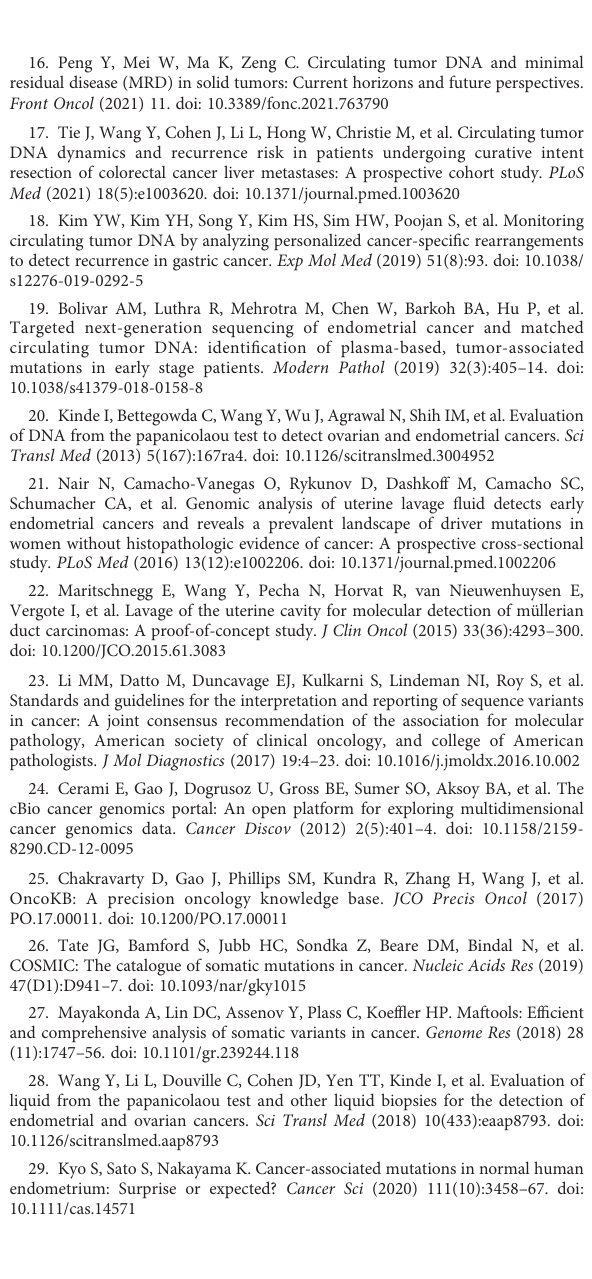
SUPPLEMENTARY FIGURE 2 Genetic alteration pro fi le. (A) Most commonly altered genes based on cervical swab-based genomic DNA (left) and whole blood-based circulating tumor DNA (right). (B) Frequently highlighted pathways based on cervical swab-based gDNA from 26 patients. Number of patients with affected pathway is shown on the right; fraction of patients with affected pathway is shown on the bottom. (C) Top 3 most frequently mutated pathway, including speci fi c genes involved. SUPPLEMENTARY FIGURE 3 Lollipop plot of somatic nucleotide level mutations for genes, including PTEN , PIK3CA,TP53,MSH2,MSH6,andPOLE